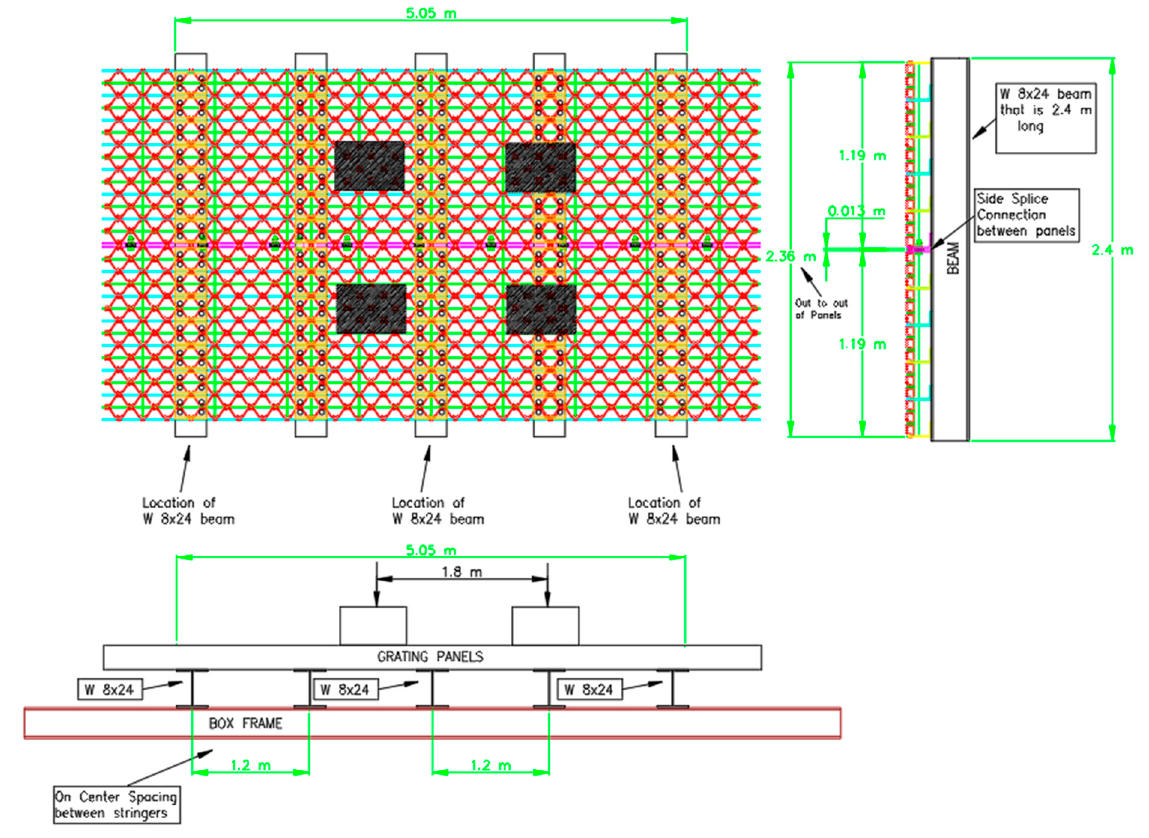
Figure 1. A 37R5 L-series L 127 mm × 76 mm × 6.35 (L 5 ″ × 3 ″ × 1/4 ″ ) panel.